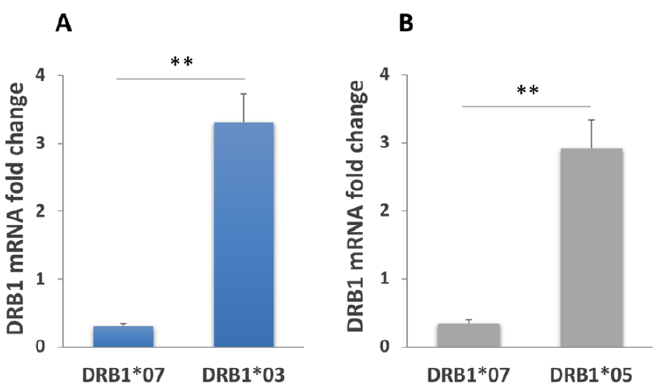
Figure 3. Expression of DRB1 alleles. ( A ) DRB1*03 mRNA is 11-fold more expressed than the DRB1*07 transcript in macrophages carrying the DR3/DR7 genotype ( n = 4: CD20, CD25, CD31, and CD35). ( B ) DRB1*05 mRNA is 8.3-fold more abundant than the DRB1*07 mRNA in M Φ with the DR5/DR7 genotype ( n = 5: CD07, CD11, CD21, CD26, and CD55). (** p < 0.01).